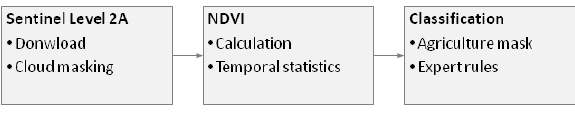
Figure 4. Methods used for crop